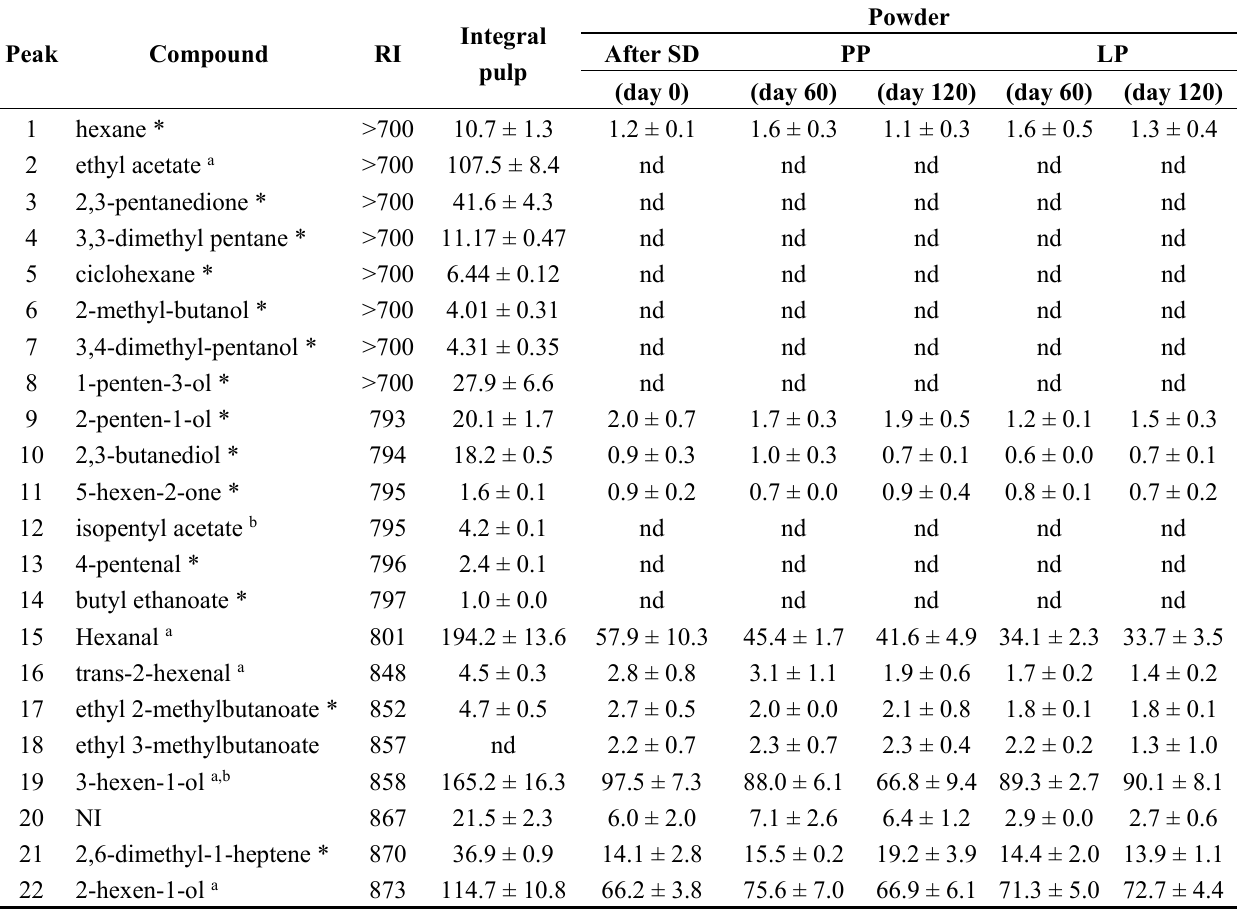
Table 1. Volatile compounds of red mombin ( Spondias purpurea ) pulp and powder stored at 0, 60 or 120 days in plastic (PP) or laminated packages (LP). Each value represents the mean ± SD (×10 6 chromatogram units) of three analyses of different